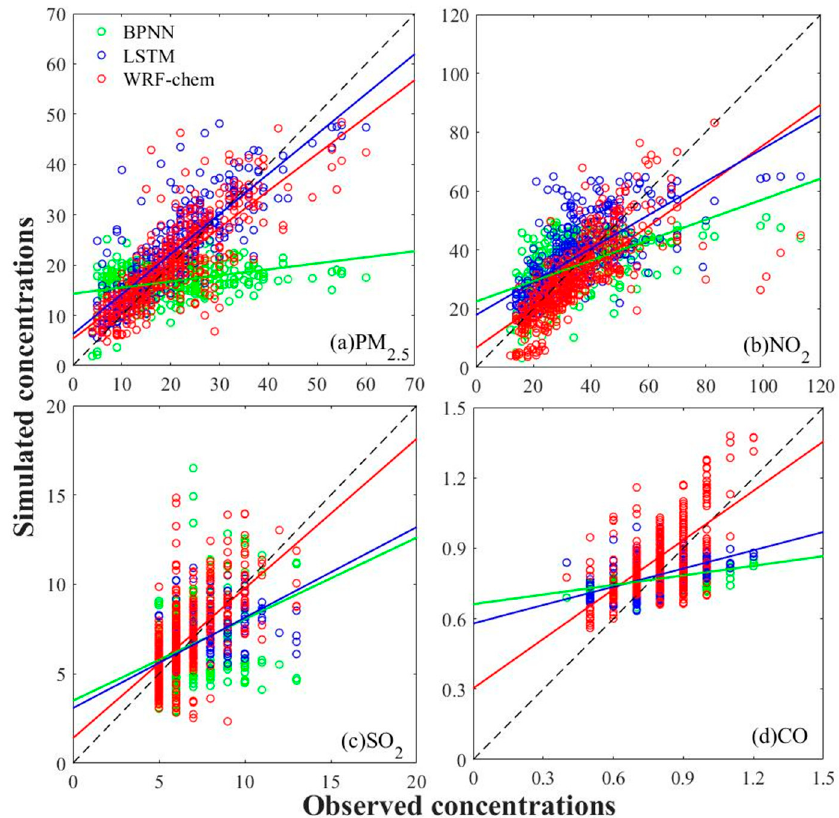
Figure 9. Quantile–quantile plotted for the ( a ) PM 2.5 , ( b ) NO 2 , ( c ) SO 2 , and ( d ) CO concentrations. The black-dashed lines were the 1:1 lines as the reference. The units were µ g m − 3 , µ g m − 3 , µ g m − 3 , and mg m − 3 , respectively. Red circles represent the WRF-Chem simulations, blue circles represent the LSTM simulations, and green circles represent the BPNN simulations.